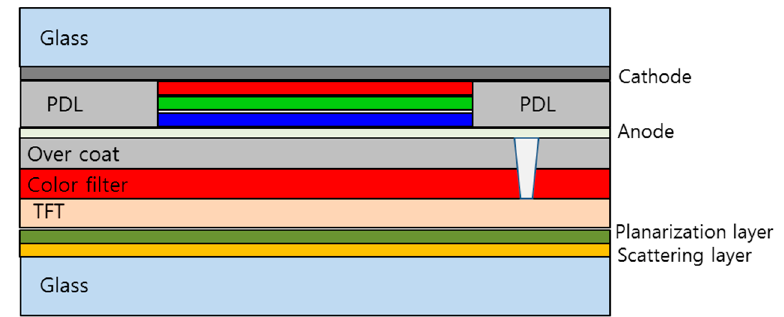
Figure 2. Schematic diagram of the bottom emission white OLED device with the scattering layer on the inner side of glass substrate.